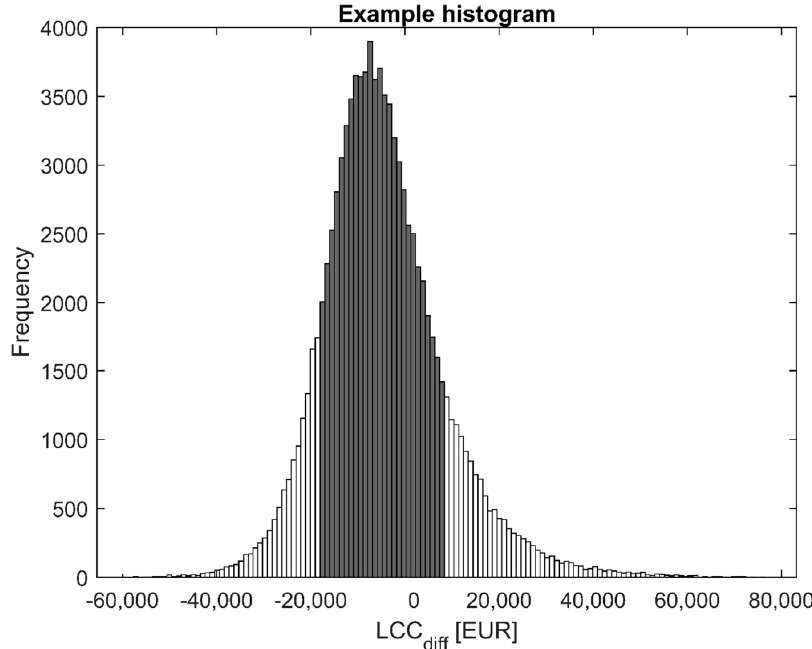
Figure 3. A histogram showing the results, here illustrated with the outcome of scenario 1. The grey bars represent the results within one standard deviation.